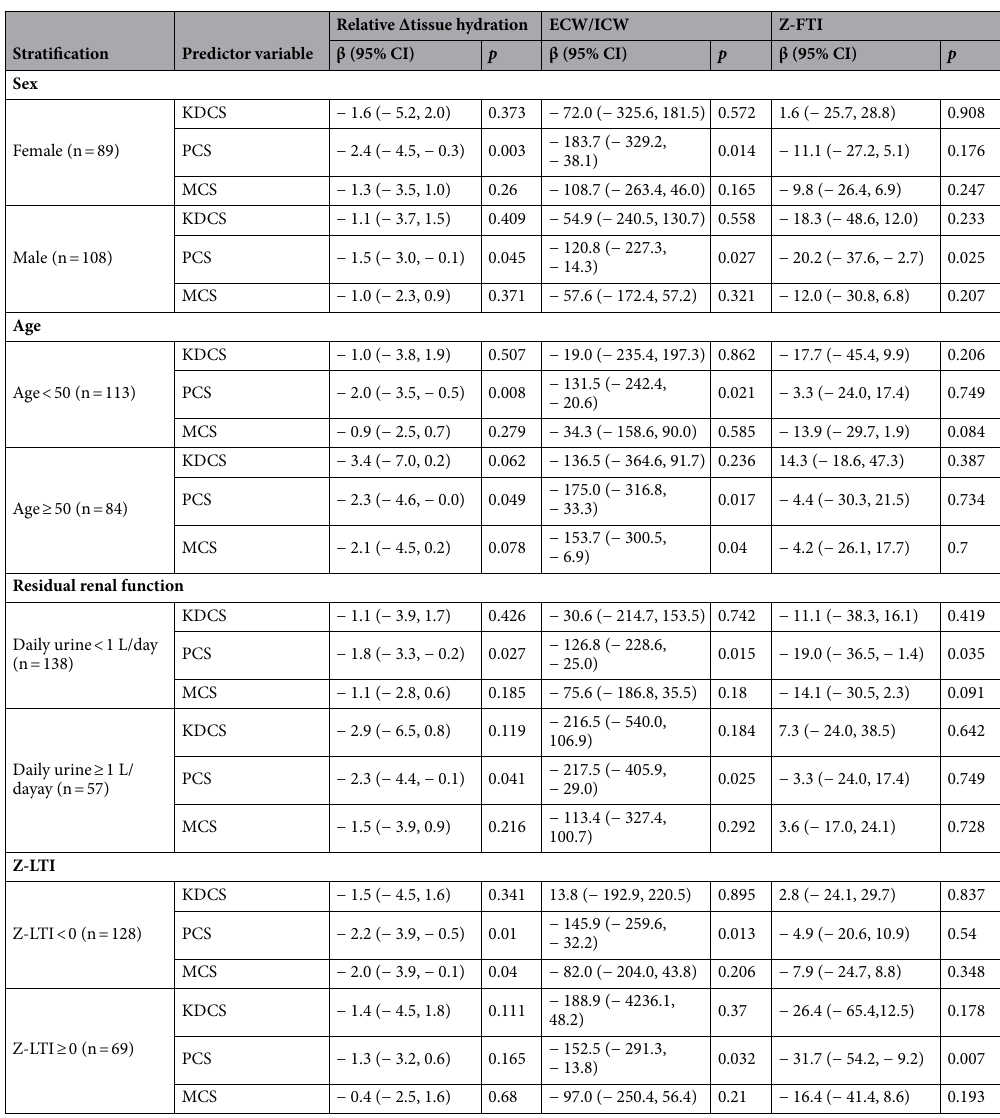
Table 5. Subgroup analysis of regression coefficient of the body composition parameters for HRQOL scores. HRQOL health related quality of life, ECW extracellular water, ICW intracellular water, Z-FTI Z-score of